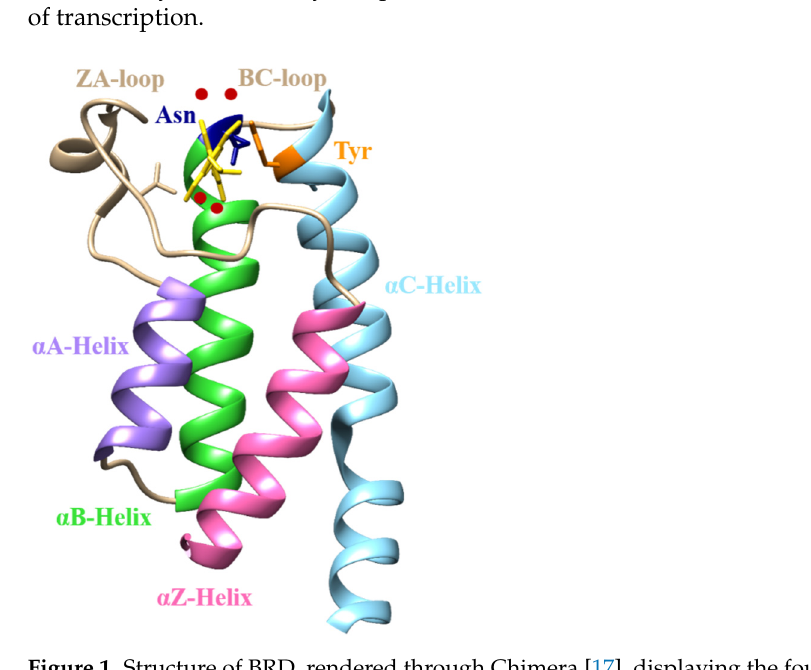
Figure 1. Structure of BRD, rendered through Chimera [17], displaying the four antiparallel alpha helices ( α A, α B, α C, α Z) and loop regions (ZA and BC) forming an acetyl binding pocket with conserved water molecules (red sphere).